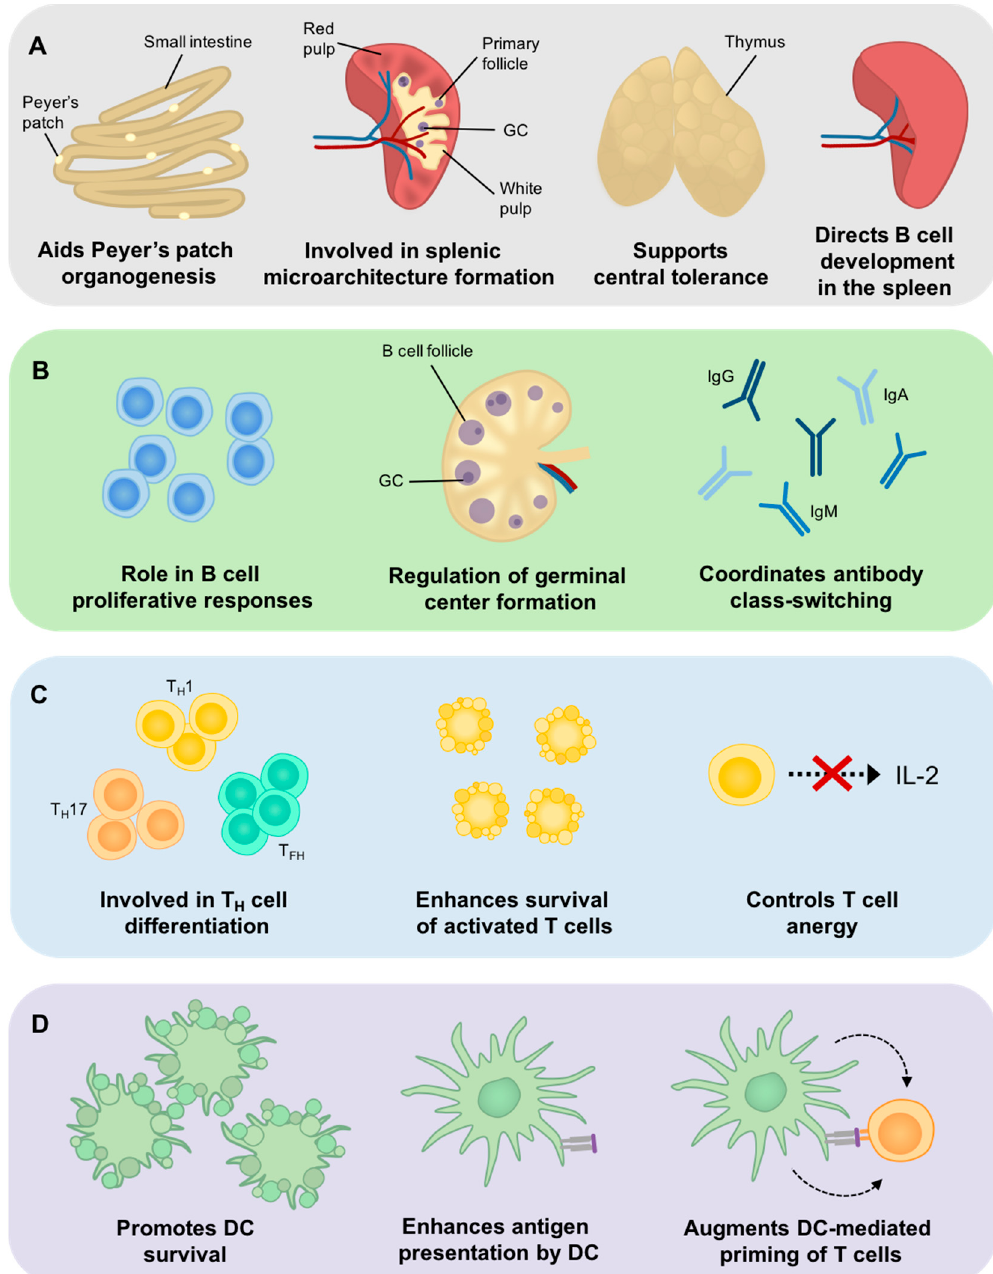
Figure 1. Bcl-3 is involved in the development and function of the adaptive immune response. ( A ) Bcl-3 is an important factor in the development of the adaptive immune system, with roles in the organogenesis of secondary lymphoid organs (SLOs), such as Peyer’s patches, the correct formation of splenic microarchitecture, the induction of central T cell tolerance in the thymus, and the development of lymphocytes within SLOs; ( B ) Bcl-3 is crucial to the regulation of B cell proliferative responses, effective germinal center (GC) formation and the production of class-switched antibodies; ( C ) Bcl-3 is involved in the differentiation and development of T H cell subsets in the periphery, acts as a survival factor in activated T cells, and has been implicated in the induction of anergy in CD4 + T cells; ( D ) Bcl-3 promotes DC survival, and enhances successful antigen presentation and T cell priming by DCs.